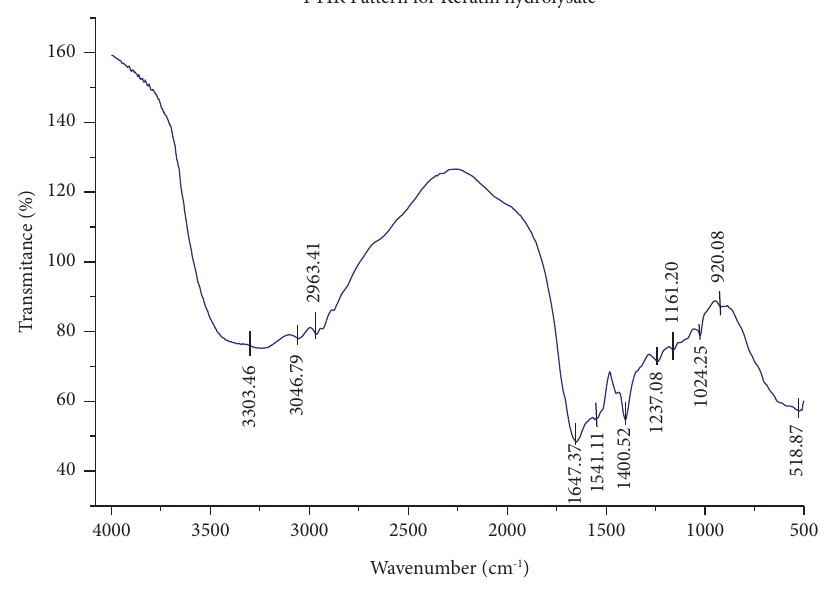
Figure 7: FTIR pattern for the extracted